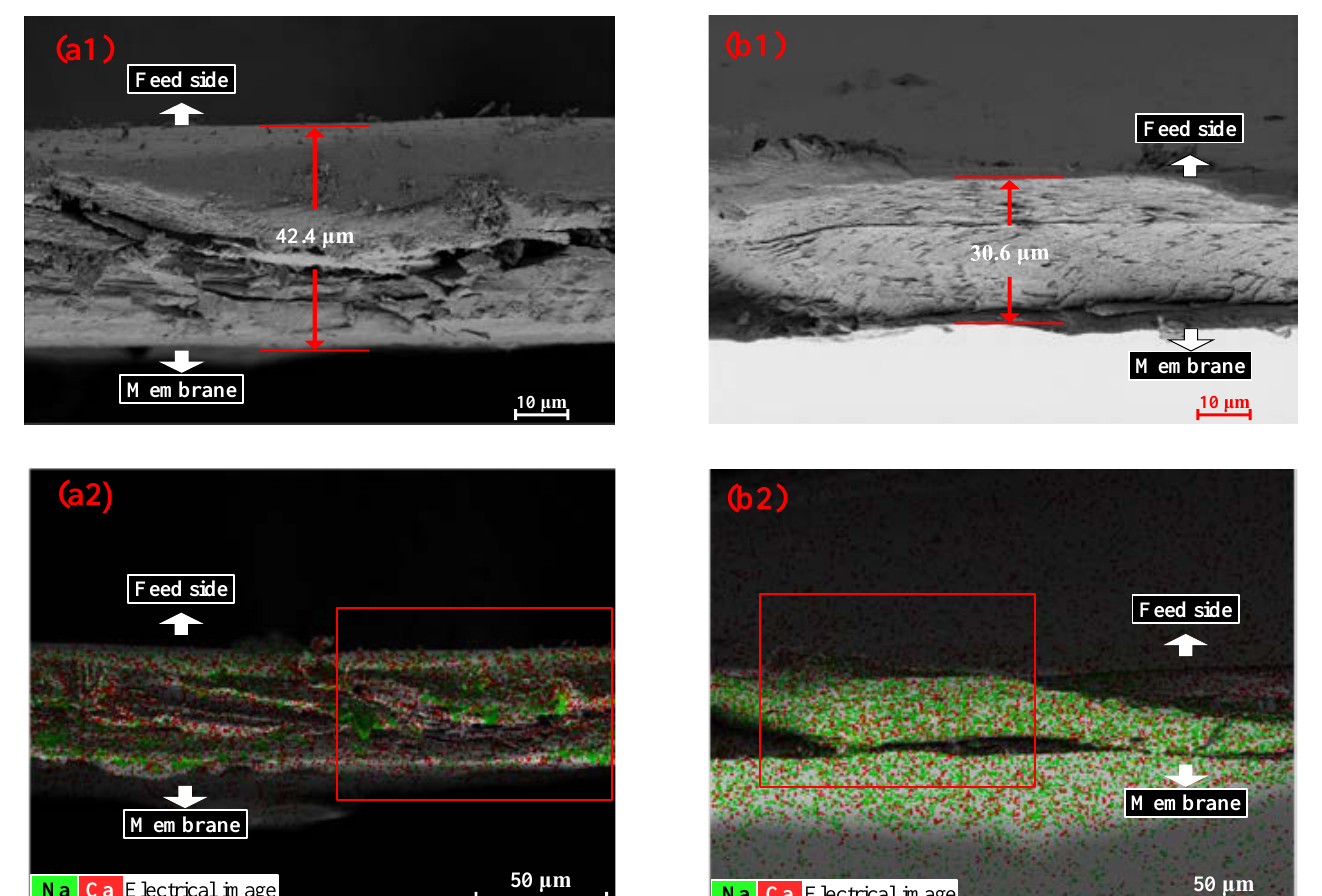
Figure 5. SEM morphology ( a1 ) and ( b1 ) and EDS images ( a2 ) and ( b2 ) of Ca and Na elements in the cross-sectional profile of CARP. ( a1 ) and ( a2 ) are CARP images for 1.0 g/L SA solution as the FS and 1 M CaCl 2 solution as the DS, where ( a1 ) represents the red box in ( a2 ); ( b1 ) and ( b2 ) are CARP images for 1.0 g/L SA solution as the FS and 3 M CaCl 2 solution as the DS, where (b1) represents the red box in ( b2 ).